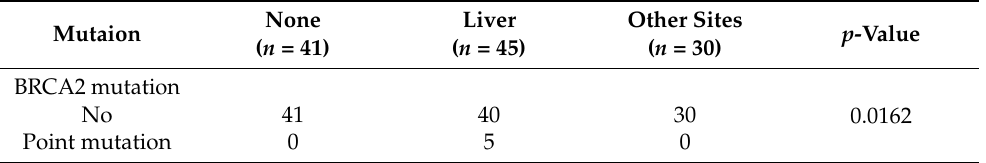
Table 2. Genetic Alterations Significantly Associated with Metastatic sites.